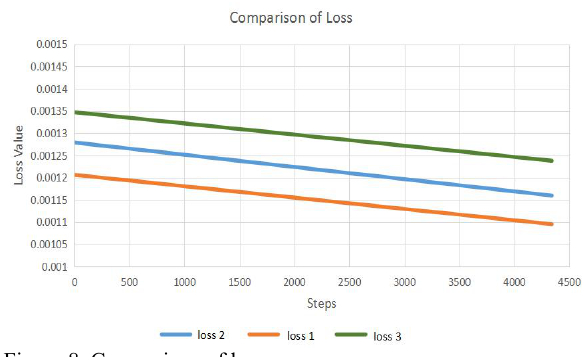
Figure 8. Comparison of loss.